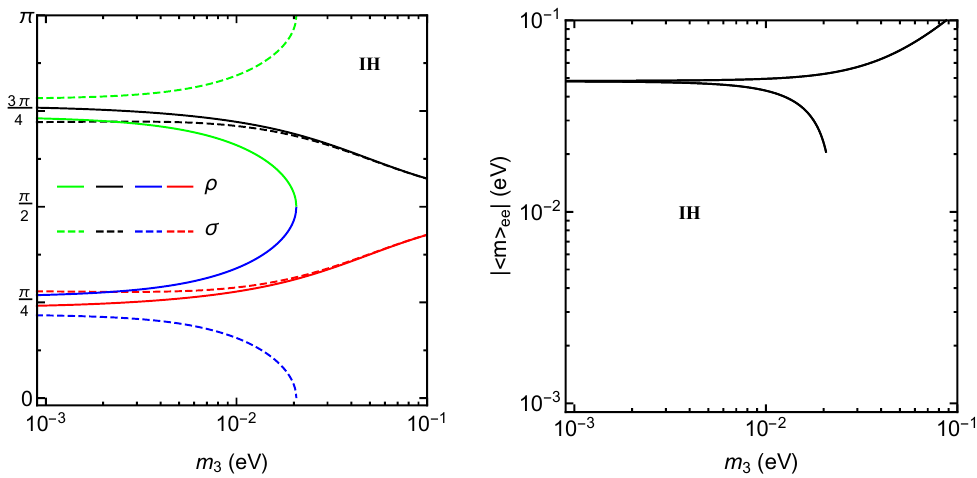
Figure 9 . (cid:26) , (cid:27) and jh m i of equations B, C and F being